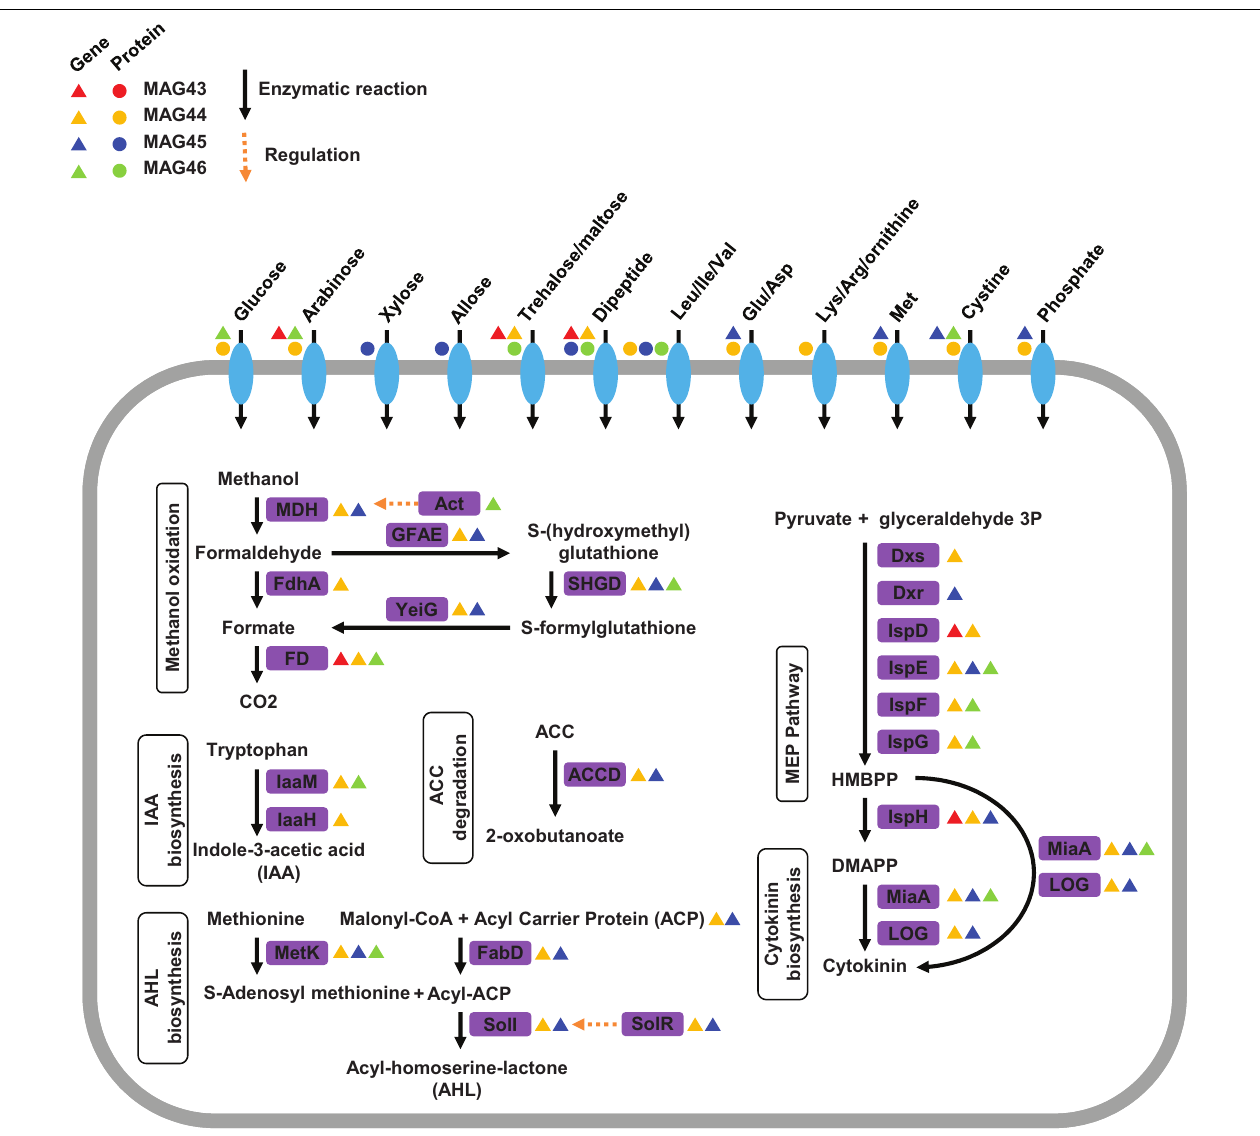
FIGURE 2 | Phytohormone modulation, nutrient transportation, quorum sensing, and methanol metabolism in the four 13 C-labeled microorganisms. Enzymes in purple boxes are labeled with triangles for encoded genes and circles for expressed proteins in these microorganisms. The triangles and circles are color-coded for each microorganism. MDH: NAD-dependent methanol dehydrogenase, Act: methanol dehydrogenase activator, FdhA: glutathione-independent formaldehyde dehydrogenase, FD: formate dehydrogenase, GFAE: glutathione-dependent formaldehyde-activating enzyme, SHGD: S-(hydroxymethyl)glutathione dehydrogenase, YeiG: S-formylglutathione hydrolase, laaM: tryptophan 2-monooxygenase, laaH: indole acetamide hydrolase, MetK: methionine adenosyltransferase, ACCD: 1-aminocyclopropane-1-carboxylate deaminase, FabD: malonyl CoA-acyl carrier protein transacylase, Soil: acyl-homoserine-lactone synthase, SoIR: